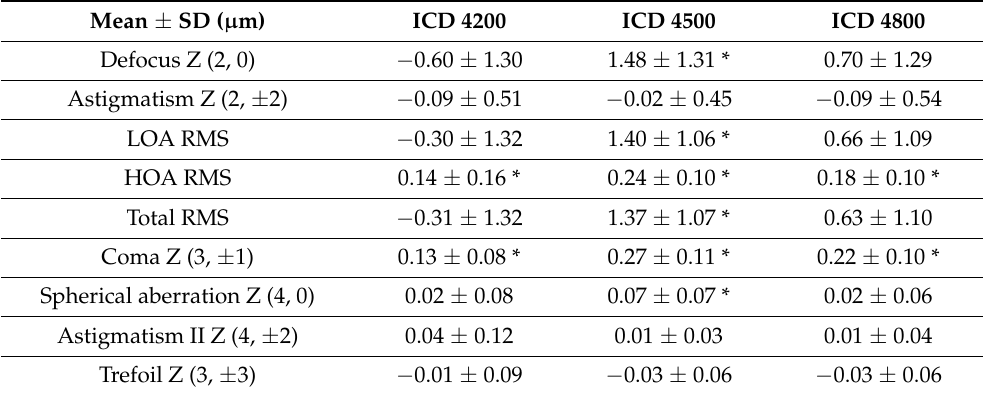
Figure 4. Ocular aberrations obtained before lens wear (light grey) and with the different scleral lenses (ScCL) fitted of sagittal heights 4200 µm (white), 4500 µm (grey) and 4800 µm (black). There were significant differences between the different mean values. * p < 0.05; Wilcoxon test, Bonferroni test. Error bars represent SD. Table 3. Differences in the ocular aberrations measured with the three ScCLs fitted with respect to before fitting. * p < 0.05; Wilcoxon test, Bonferroni test.